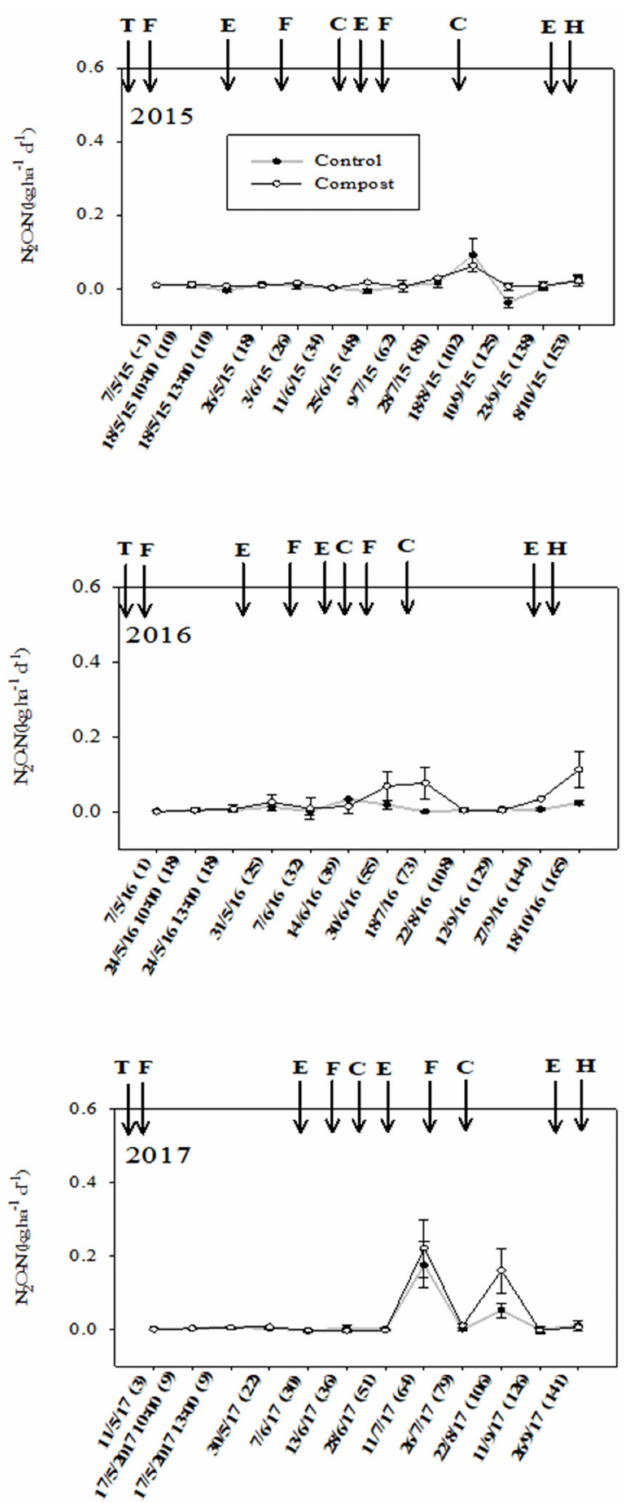
Figure 3. Effect of different management systems on N 2 O emission throughout the rice growing cycle. The error bars represent the standard error of the mean. T: Tillage and fertilizer, C: Cover fertilizer, F: Flood, E: Emptying of terraces, H: Harvest. The numbers in parentheses on the x -axis indicate days after sowing